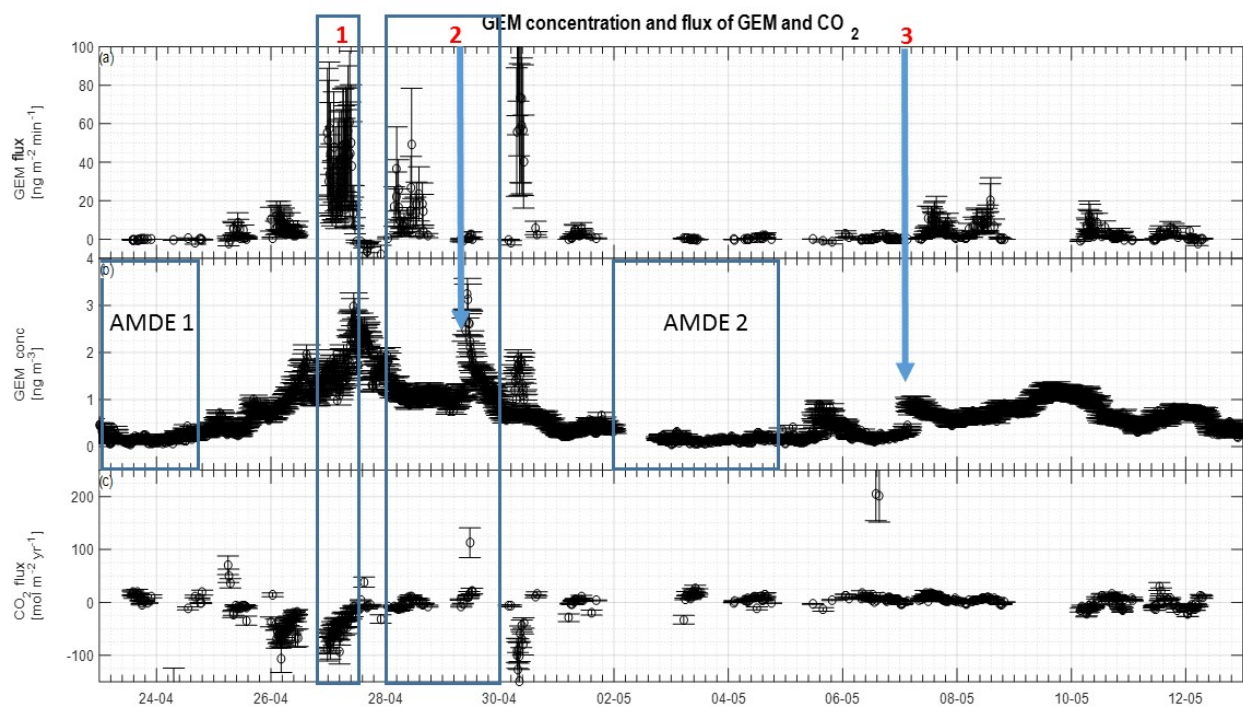
Figure 8. GEM concentration and fluxes of CO 2 and GEM over time. (a) GEM flux in ngm − 2 min − 1 , (b) GEM concentration in ngm − 3 and (c) CO 2 flux in molm − 2 yr − 1 . Three events and two AMDEs are highlighted. The arrows show the specific case of stability change referred to in the